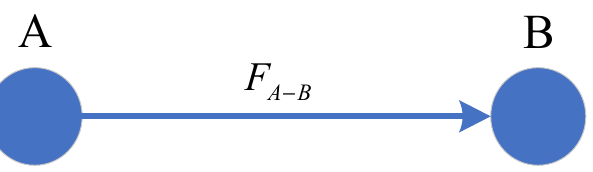
Figure 8. The corresponding relationship of full load ratio and adjacent stations.